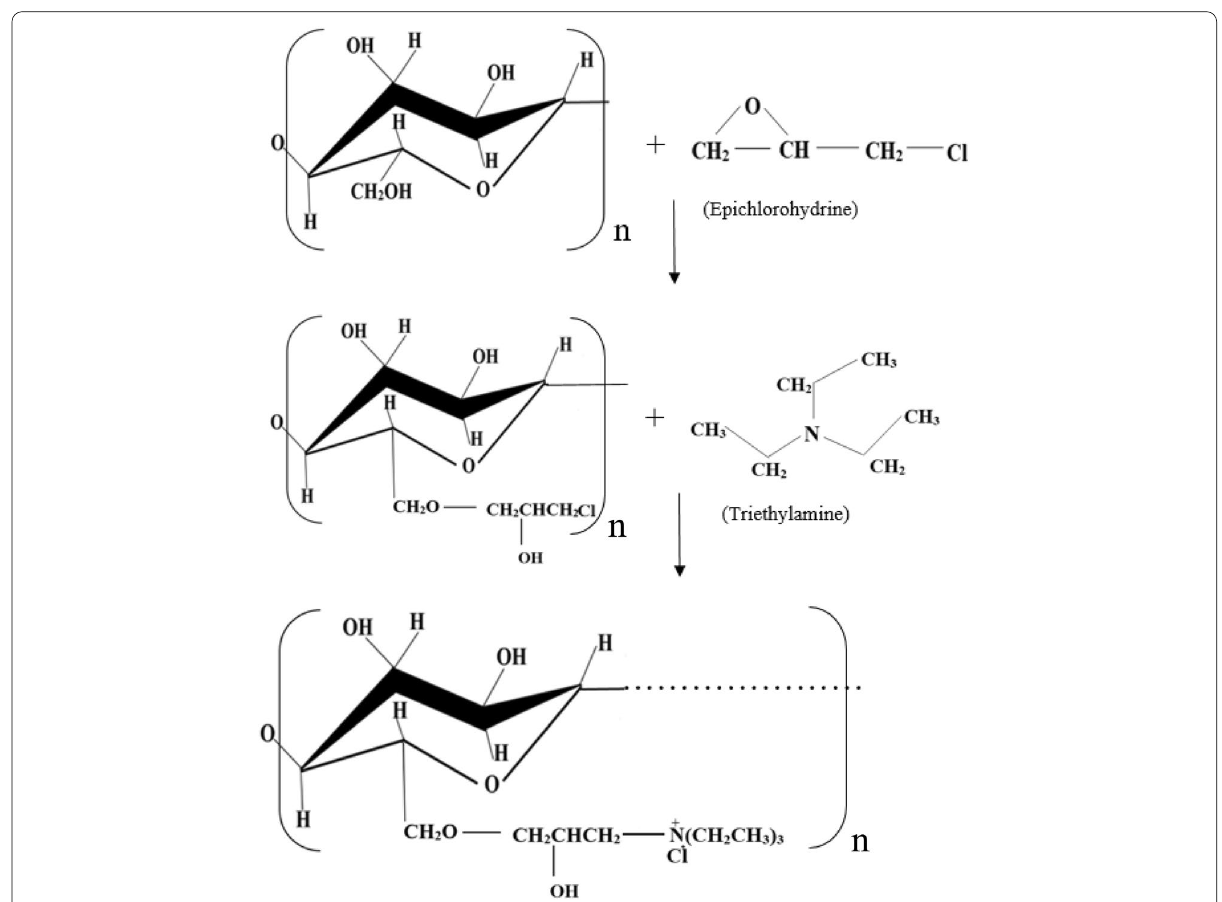
Fig. 1 Synthesis reactions for the cationization of cellulose fibers